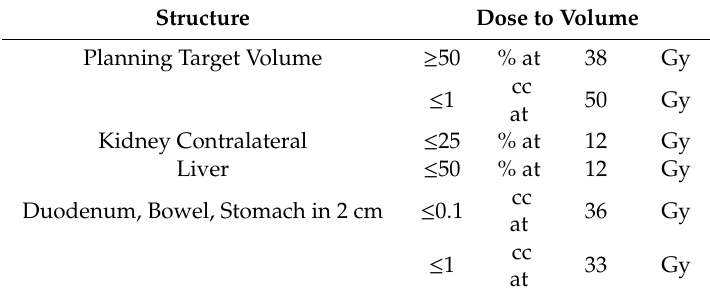
Table1. Doseprescriptionforinstitutionaltargetcoverageandnormaltissueconstraints. Theconstraints represent the cut-o ff doses for radiotherapy planning with the aim of dose sparing in the surrounding organs (contralateral kidney, liver, duodenum, bowel, and stomach) while, at the same time, aiming to achieve a high dose in the tumor with the margin, which is represented as the planning target volume. Organs at risk are only re-contoured within 2 cm of the tumor and, for an adaptive setting, only the dose in these structures are optimized.